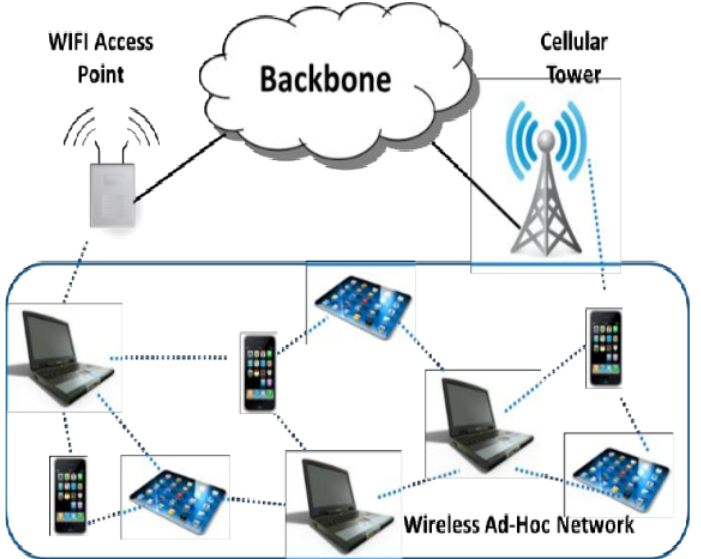
Figure 1. Mobile ad hoc networks structure.